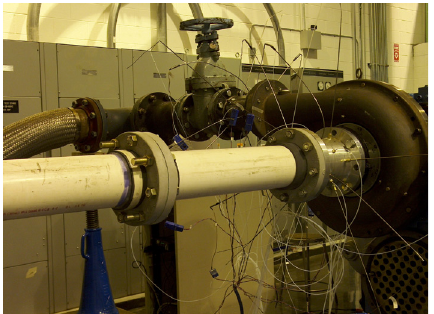
Figure 2: Ingersoll-Rand test rig of the single-stage compressor. The inlet pipe is the white pipe coming from the left of the image. The compressor discharges through the flex hose visible just above the inlet pipe. The regulating butterfly valve can be seen in the back- ground.